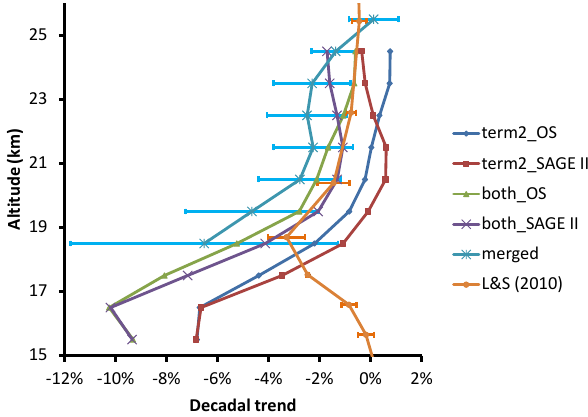
Fig. 6. Observed and calculated ozone trends for 1984–2005. The observed trend is labelled “merged” and is the trend shown in Fig. 4 for the merged data set. The trend profiles labelled “both_OS” and “both_SAGE II” are calculated trends including contributions from the trend in tropical upwelling and the trend in the vertical gradi- ent of ozone, with the vertical gradient of ozone supplied by ei- ther OSIRIS or SAGE II. The profiles labelled term2 consider only the contribution from the trend in the vertical gradient of ozone (see Sect. 4.1 for details). L&S (2010) is the model simulations of Lamarque and Solomon (2010) for 1979–2005 and 20 ◦ S–20 ◦